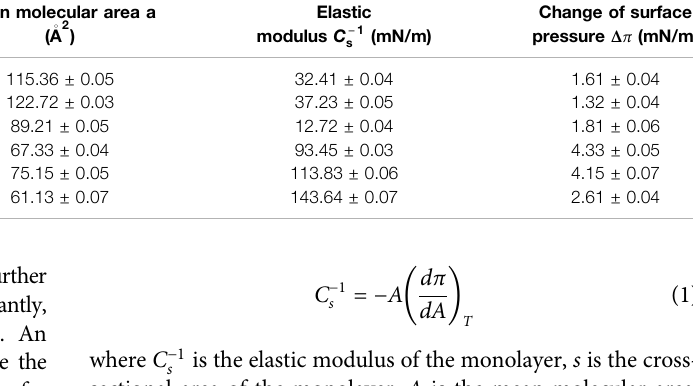
Figure 4B . In the presence of InP/ZnS-COOH QDs, the value reached the minimum at the surface pressure of 21.1 mN/ of C − 1 s m, which was closed to the surface pressure (20.1 mN/m) in the absence of InP/ corresponding to the minimum of C − 1 s ZnS QDs. Different signi fi cantly, in the presence of InP/ZnS-NH 2 QDs, the surface pressure corresponding to the minimum value reduced to 7.9 mN/m. This suggested that the InP/ZnS of C − 1 s QDs modi fi ed by the − COOH group had almost no effect on the phase transition point of the DPPC/DPPG mixed monolayer. At the region of surface pressure from 1.4 mN/m to 20.3 mN/m and values in the presence of from 24 mN/m to 41 mN/m, the C − 1 s InP/ZnS-COOH QDs were greater than those in the absence of values in the presence of InP/ InP/ZnS QDs. However, the C − 1 s ZnS-NH 2 QDs were smaller at the region of surface pressure from